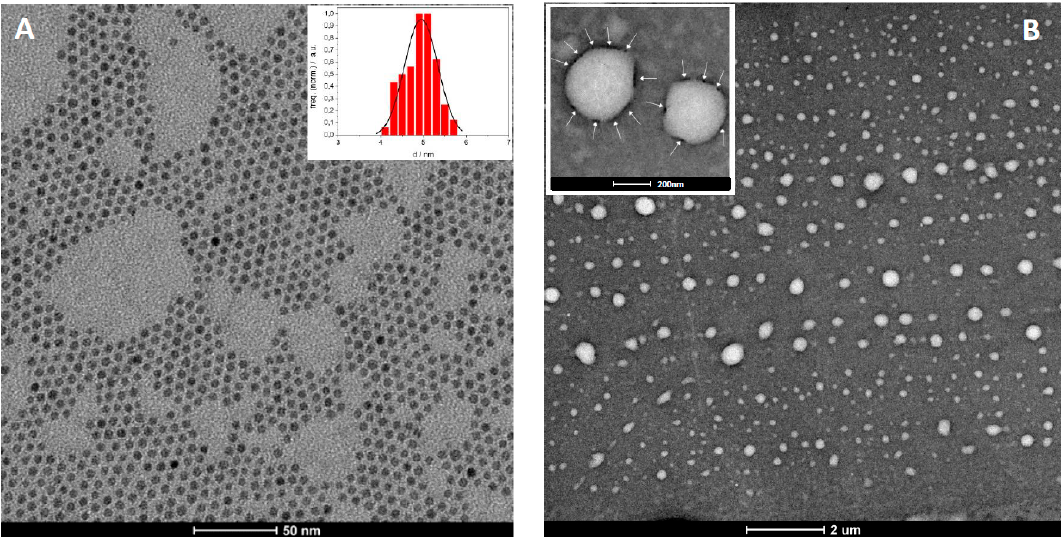
Figure 4. TEM micrographs of ( A ) as-synthesized monodisperse SPION with a size distribution of 5.0 ± 0.4 nm and ( B ) ultra-thin sections of hydrophobic SPION embedded in PBD(1200)- b -PEO(600) polymersome membranes prepared by solvent inversion at 0.5 mg/mL amphiphile concentration. The arrows in the inset indicate the locations of SPION in the membrane.